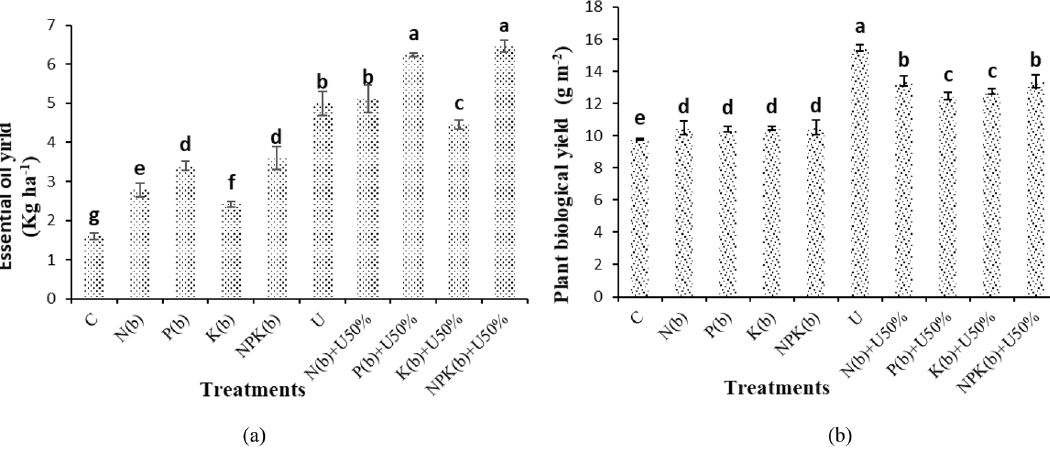
Figure 5. Means comparison for Essential oil yield and Plant bioiogical yield of Nigella sativa L. as influenced by biofertilizers and urea. Dissimilar letters show significant differences at the p ≤ 0.01 level. Control (C),